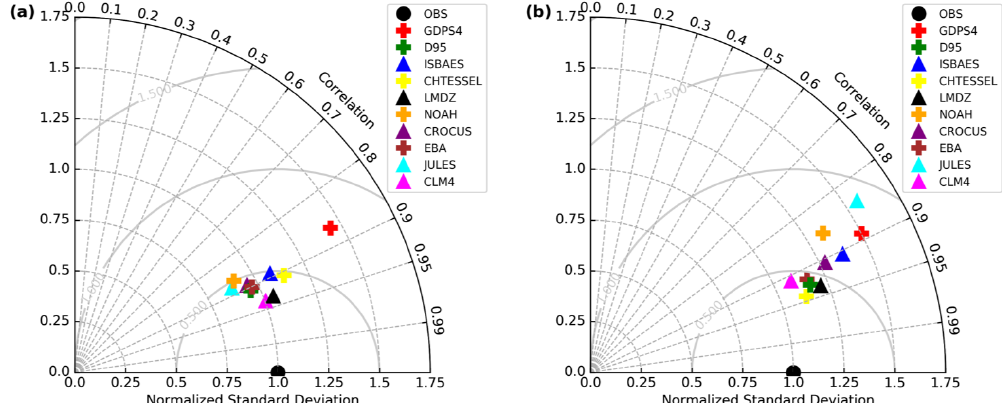
Figure 8. Taylor diagram comparing the surface temperature scores of the different models (a) during the day and (b) at night. The crosses correspond to single-layer models and the triangles to multilayer models.